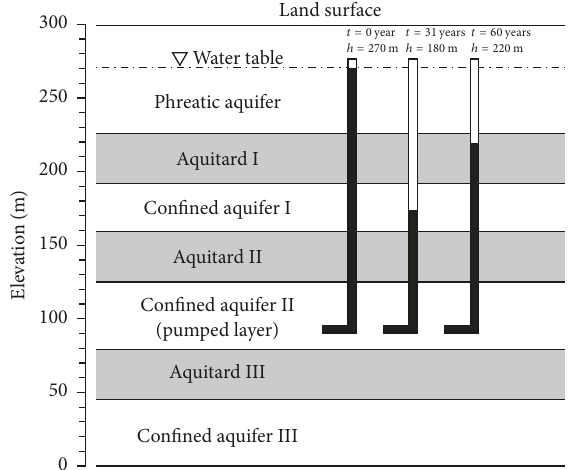
Figure 1: Conceptual model of the multilayer aquifer system and the variation in hydraulic head of the confined aquifer II (pumped layer).